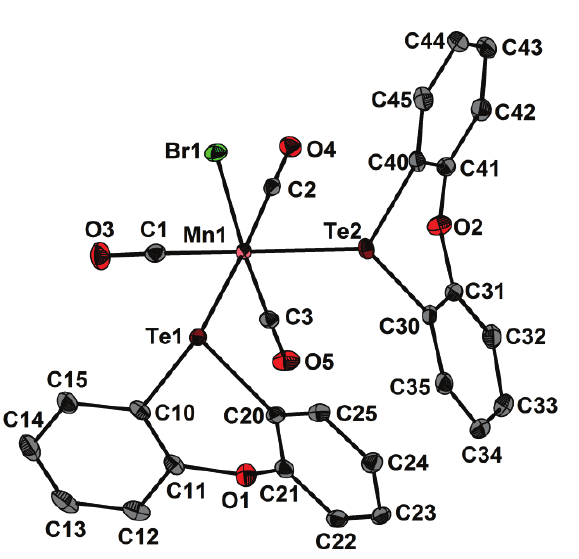
Figure 1: Molecular structure of fac -(CO) ( 2 ) showing 50% probability ellipsoids and the crystallographic numbering scheme. Selected bond